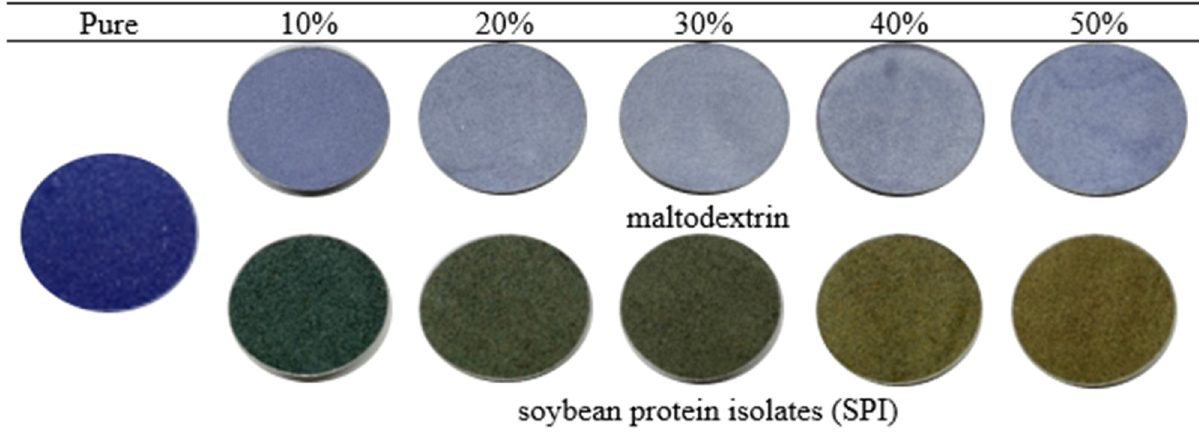
Figure 1: Image of pure butter fl y - pea extract powder ( left ) and butter fl y - pea extract powder added with maltodextrin and SPIs at 10, 20, 30, 40, and 50%